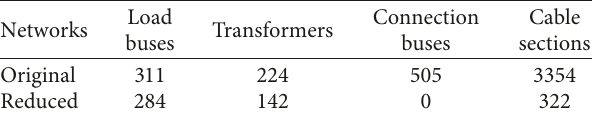
Table 1: Reduced results of a real small network in New York